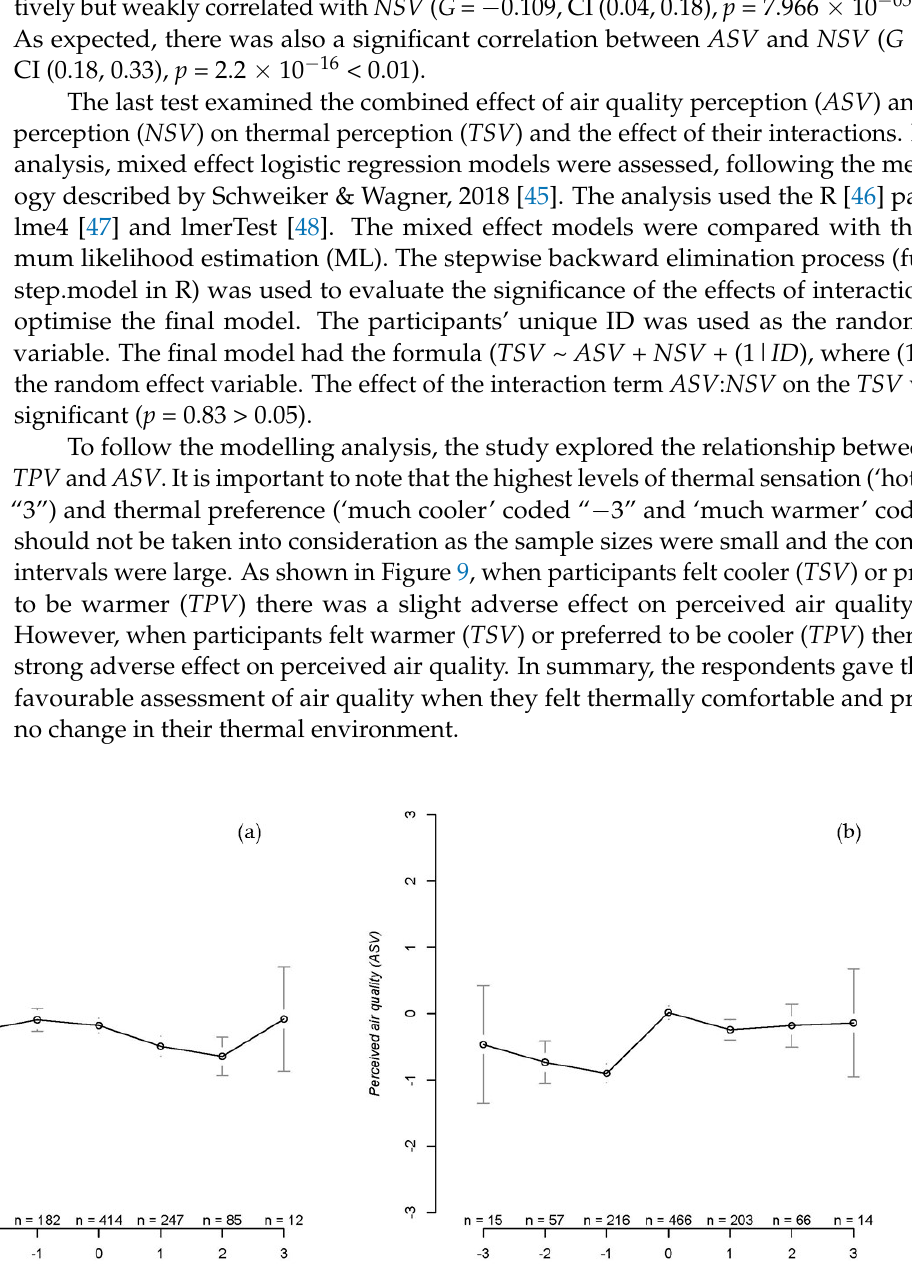
Figure 8. Comparison of agreement between air movement and air quality perception vote results for Stage 2 (the number of responses n is proportional to the area of circles).